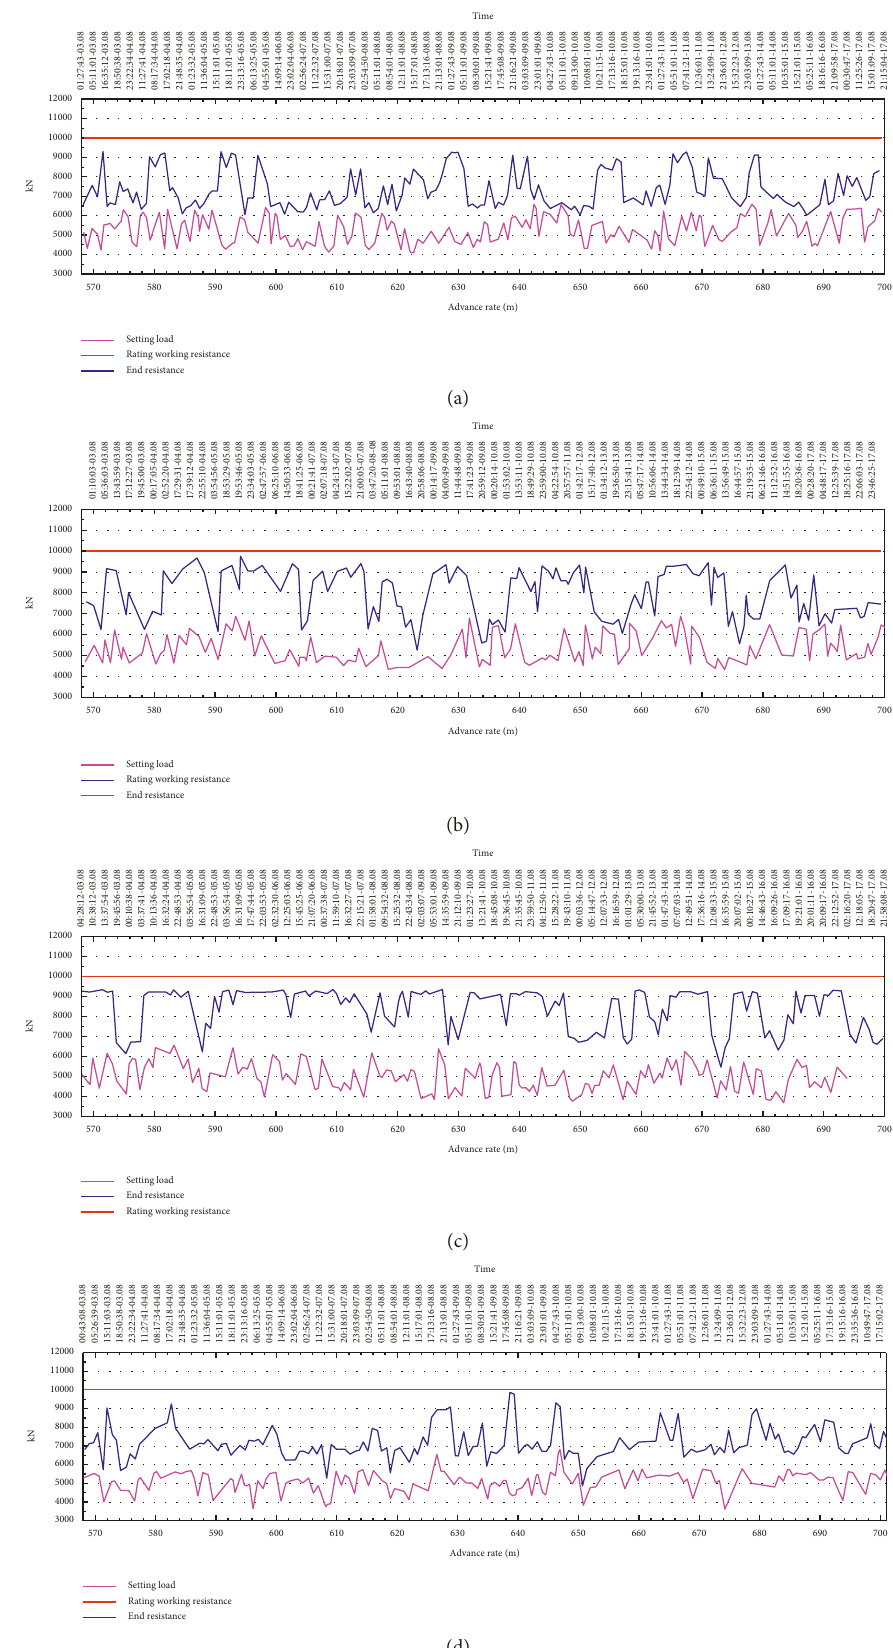
Figure 9: Working resistance distribution of hydraulic supports at different positions of working face at the normal mining stage. (a) 25# support. (b) 50# support. (c) 60# support. (d) 110#